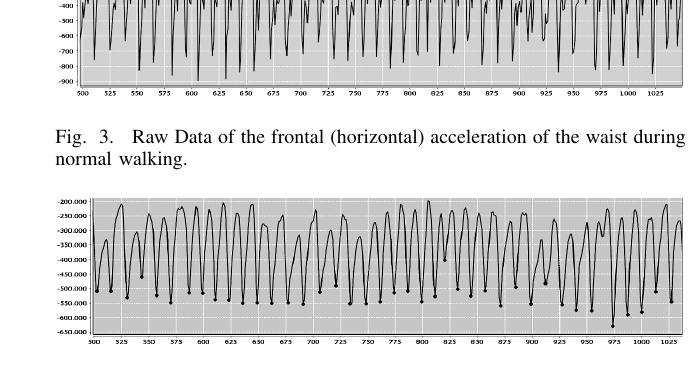
Fig. 2. Block diagram of the step-counter algorithm.